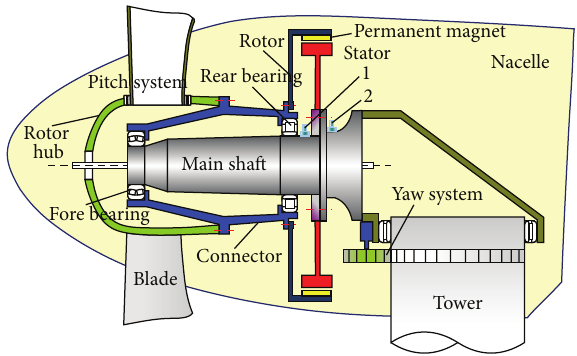
Figure 1: Structure of the direct drive wind